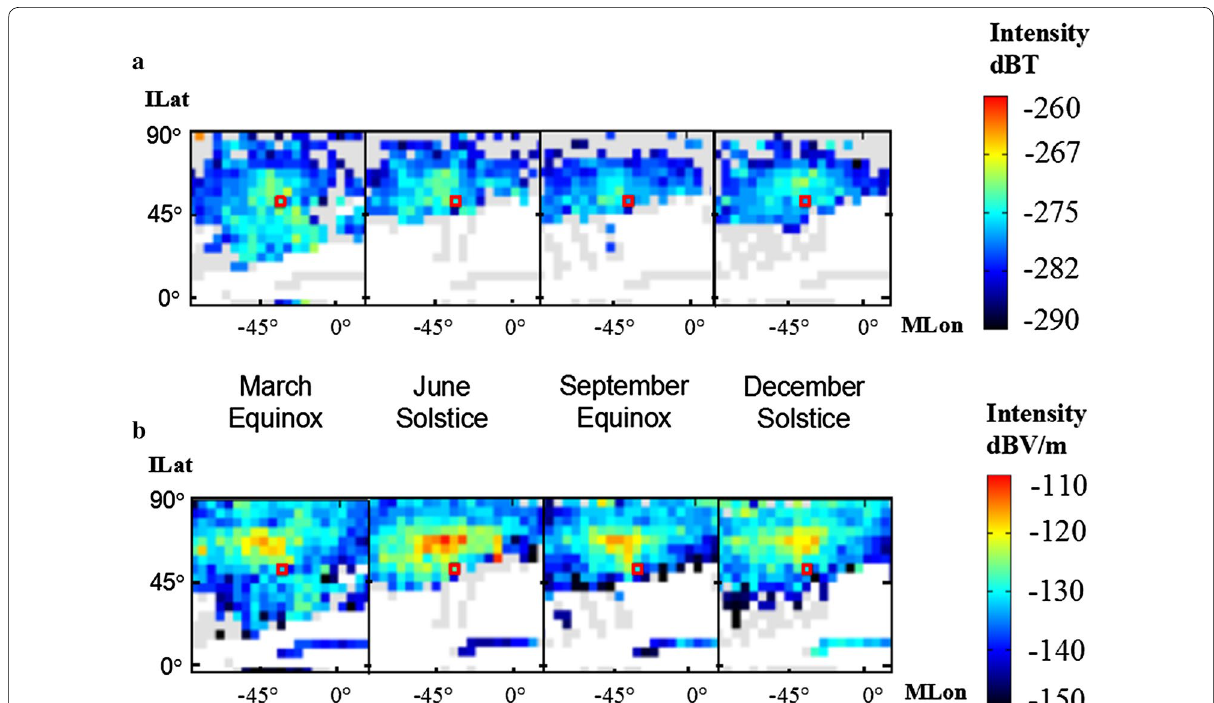
Fig. 10 a Seasonal propagation of the Omega signal from the North Dakota station in the magnetic field and b in the electric field based on invari- ant